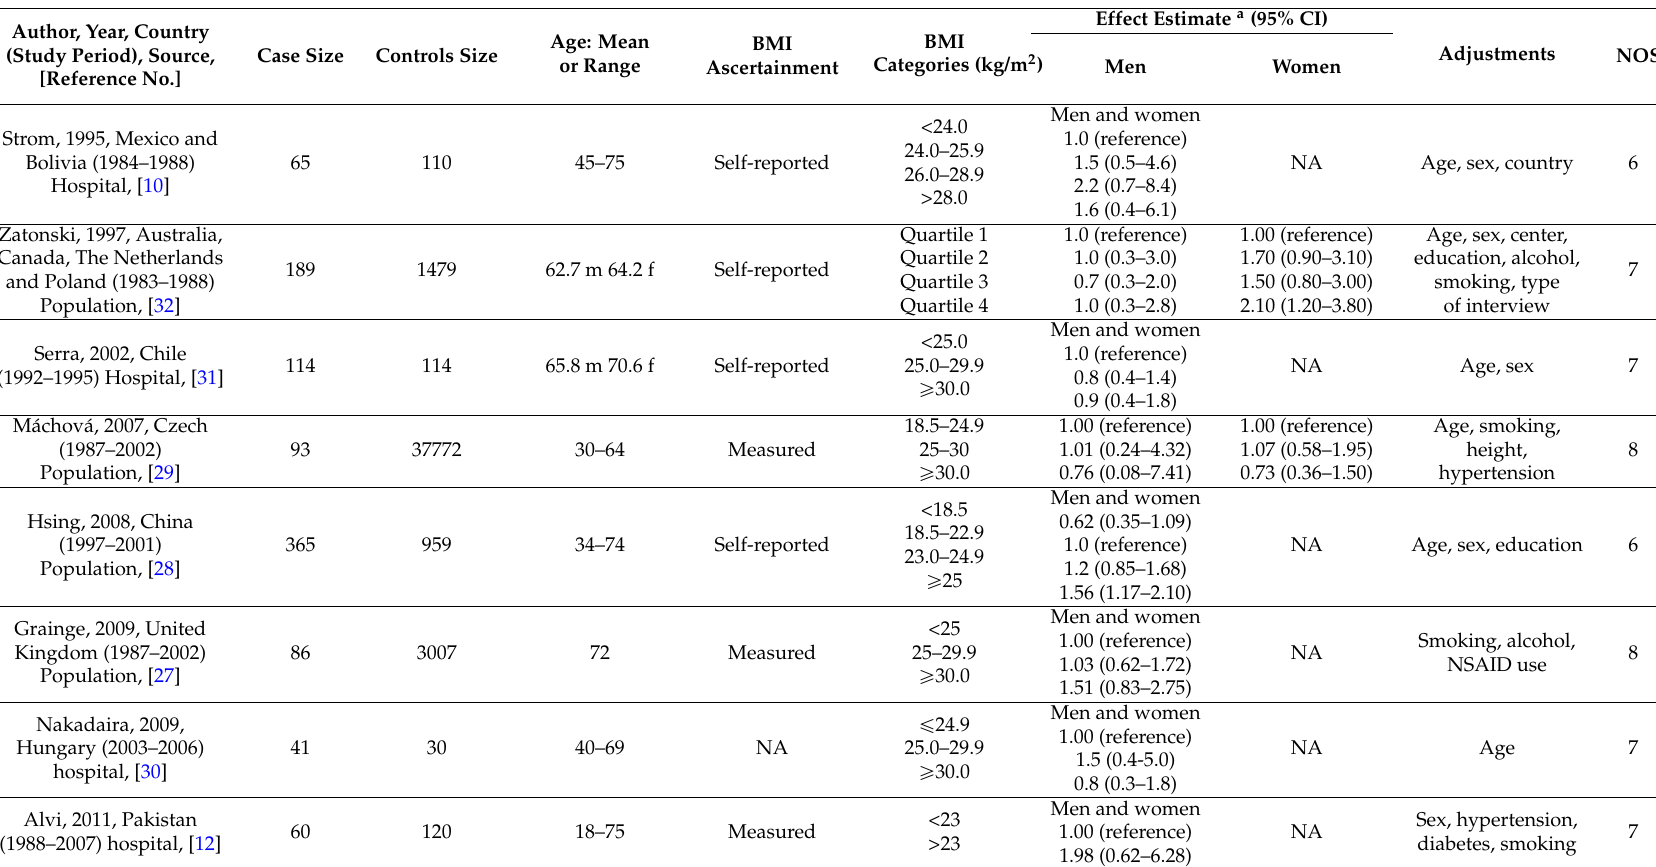
Table 1. Characteristics of eight case-control